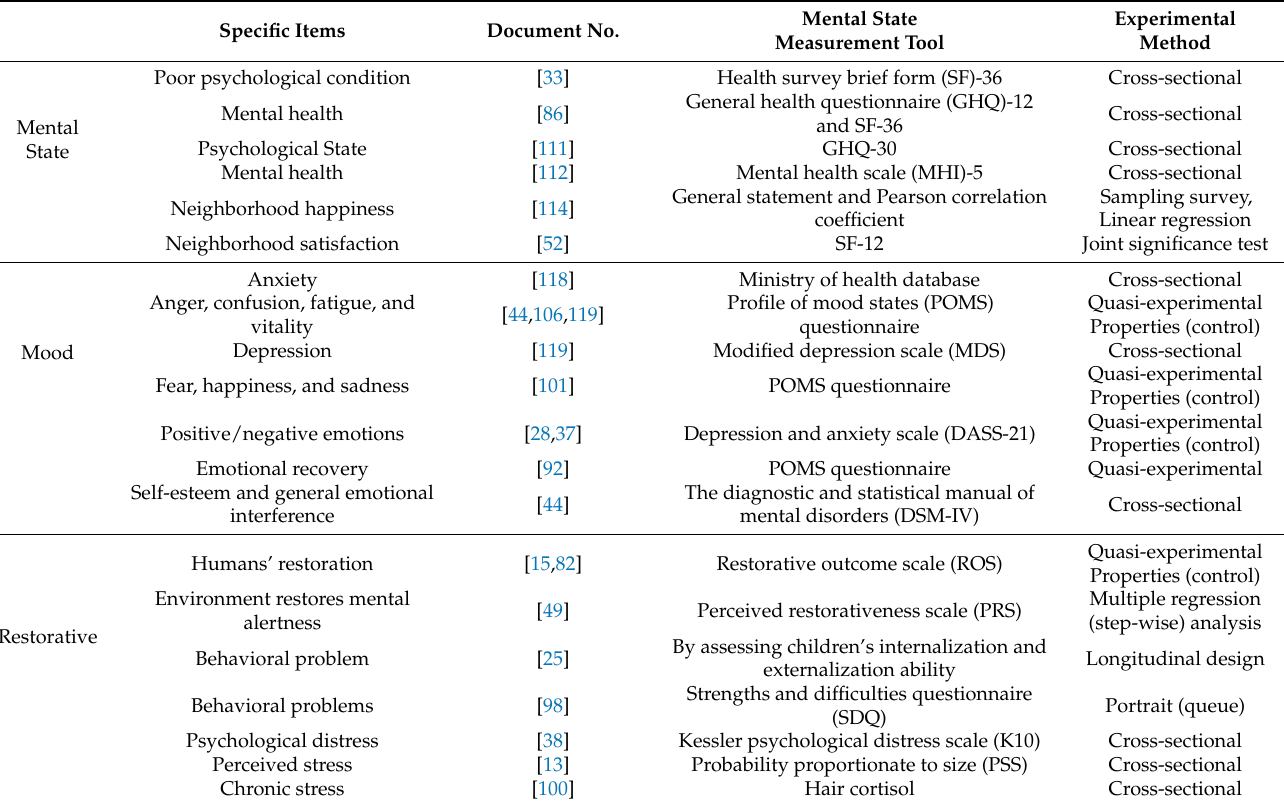
Table A2. Summary of some of the literature research methods employed in retrieved